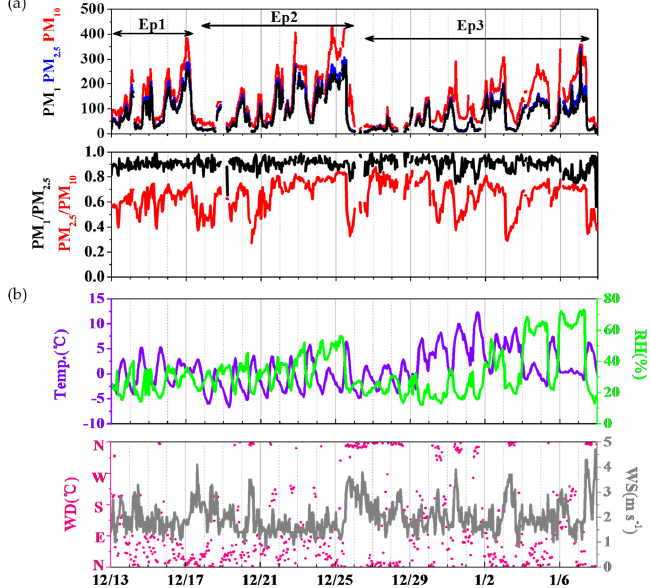
Figure 1. Time series of ( a ) mass concentration of PM 1 , PM 2.5 , PM 10 , and the ratio of PM 1 /PM 2.5 , PM 2.5 /PM 10 ; ( b ) meteorological variables (wind direction, wind speed, relative humidity, and